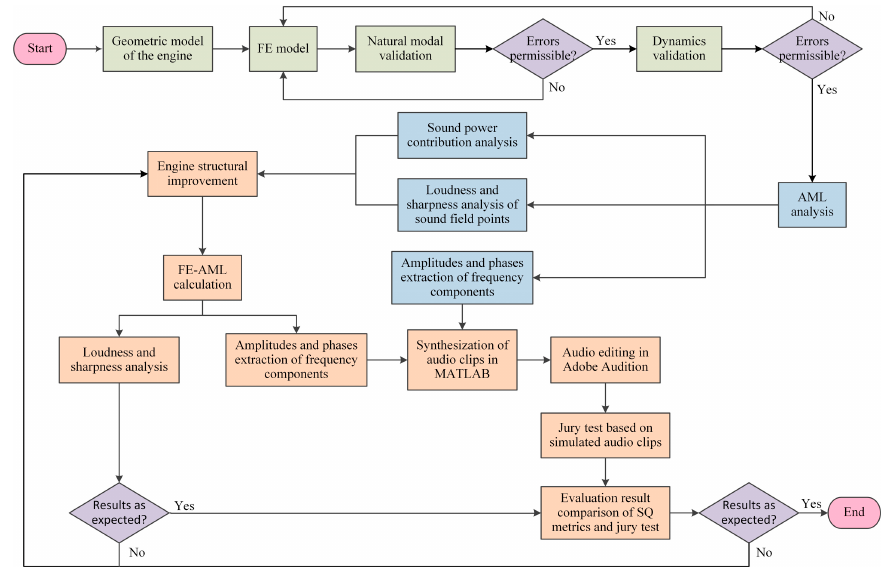
Figure 3. Flowchart of sound quality SQ evaluation, improvement, and jury test procedures of the diesel engine.